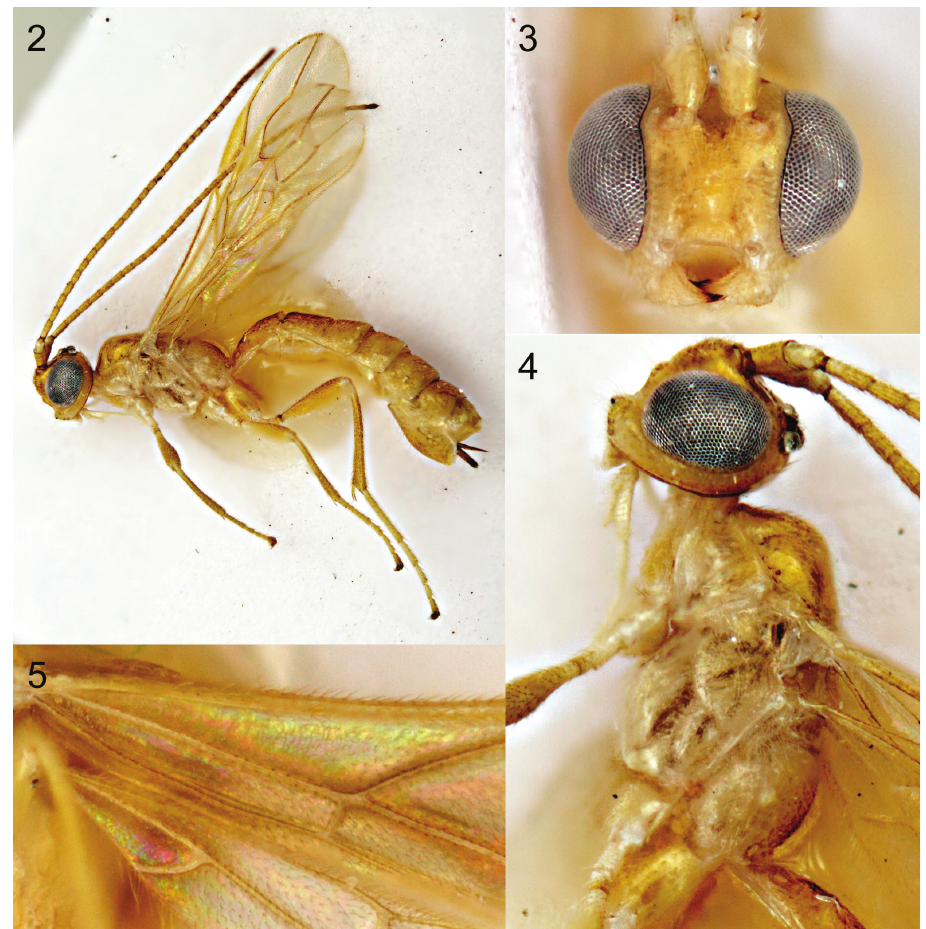
Figures 2–5. Colastomion gregarius sp. n. light photomicrographs. 2 Habitus, lateral view 3 face 4 head and mesosoma, lateral view 5 basal venation of fore wing. to weak midlongitudinal carina; rather weakly irregularly longitudinally striate with approximately 7 striate lateral to midlongitudinal carina. 3rd metasomal tergite 1.9 × wider than long; weakly irregularly longitudinally rugulose-striate basally and medially. 4 th - 6 th tergite s smooth. Coloration. Body, legs, wing venation and antennae largely pale ochreous yellow with malar region, posteroventral part of pronotum, propleuron, mesopleuron and mesosternum, metapleuron, sides of tergites 2–6 and fore and mid coxa, trochanter and trochantellus whitish; terminal 6 or 7 flagellomeres dark grey-black. Biology. Gregarious parasitoid of Glyphodes near stolalis. Etymology. Based on gregarious